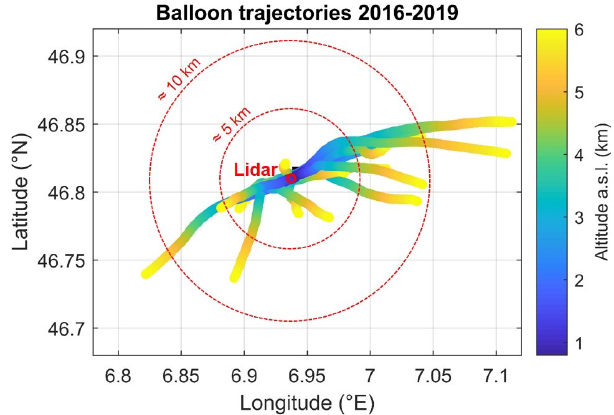
Figure 1. Balloon trajectories (longitude vs. latitude) as a func- tion of altitude (color scale) for all the analyzed soundings of the RALMO vs. COBALD comparison (17 profiles, 2016–2019). The trajectories are plotted with a vertical resolution of 30m between 0.8–6km altitudea.s.l. The location of the RALMO and CHM15K lidars (and balloon launching site) is shown by the solid red circle (46.82 ◦ E, 6.95 ◦ N). The two dotted red circles indicate horizontal distances of approximately 5 and 10km from the lidar